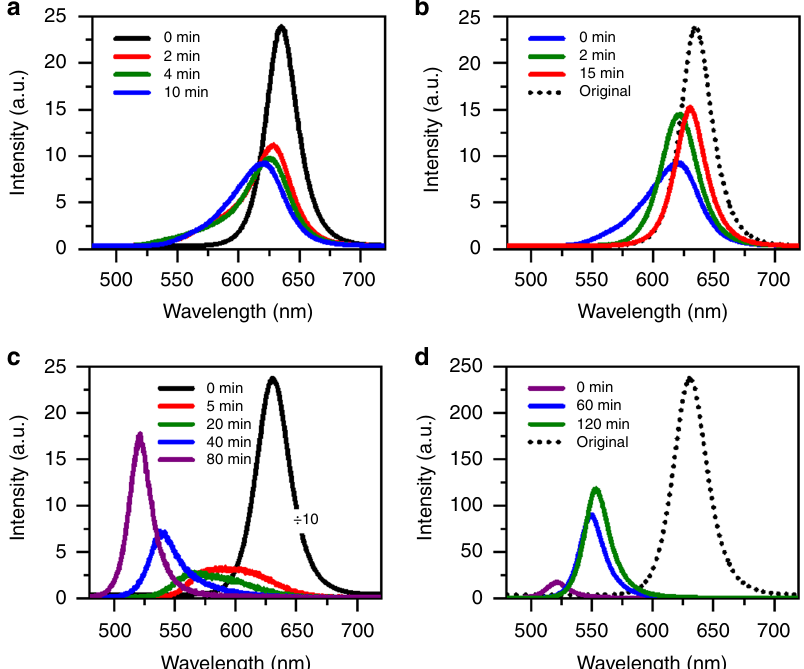
Fig. 1 Light-induced phase segregation in ensemble fi lm of CsPbBr 1.2 I 1.8 nanocrystals (NCs). a Photoluminescence (PL) spectra measured at 0, 2, 4, and 10 min for one position of the ensemble fi lm continuously excited at a laser power density of 30 W cm − 2 . The PL spectrum at each time point was acquired with an integration time of 1 s. b PL spectra measured for the same position of the ensemble fi lm after the excitation laser had then been blocked for 0, 2, and 15 min. At each time point, the laser beam was unblocked for 1 s to acquire the PL spectrum still at 30 W cm − 2 . The original PL spectrum measured at the beginning of the laser excitation in a is also plotted. c PL spectra measured at 0, 5, 20, 40, and 80 min for another position of the ensemble fi lm continuously excited at a laser power density of 15 kW cm − 2 . The PL spectrum at each time point was acquired with an integration time of 1 s. The PL spectrum measured at 0 min has been scaled down by 10 times for a good comparison. d PL spectra measured for this position of the ensemble fi lm after the excitation laser had then been blocked for 0, 60, and 120 min. At each of the above time points, the laser beam was unblocked for 1 s to acquire the PL spectrum still at 15 kW cm − 2 . The original PL spectrum measured at the beginning of the laser excitation in c is also